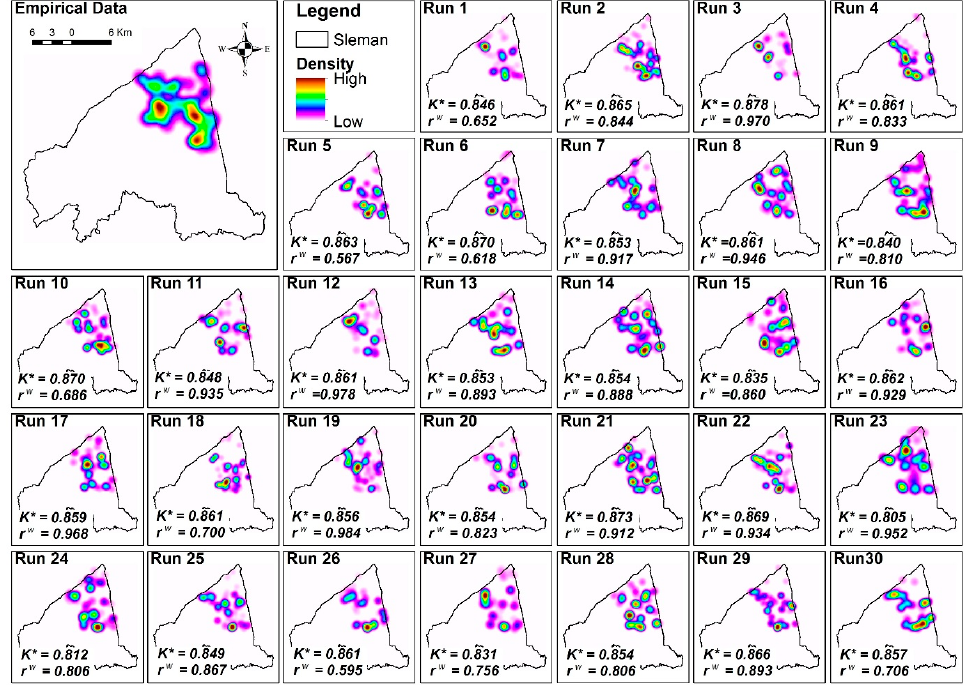
Figure 10. Spatial comparison of simulated and observed reluctance distribution based on scenario